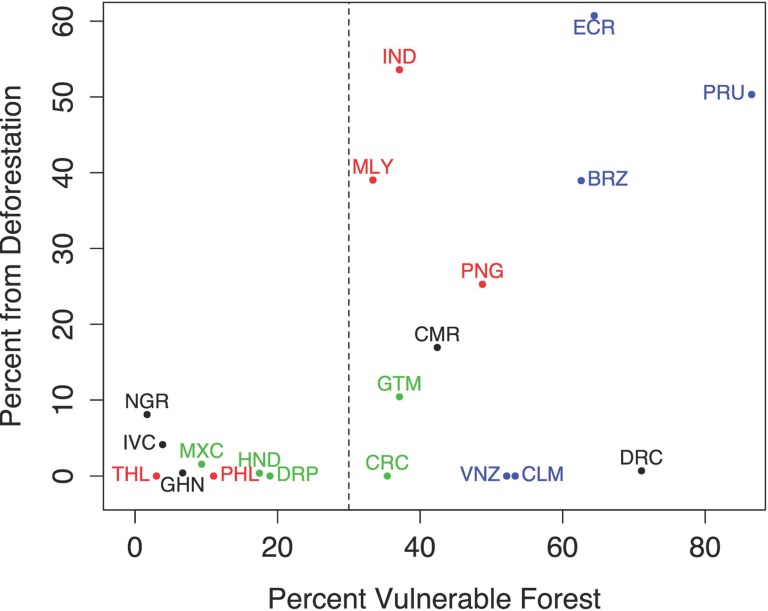
Percent deforestation versus percent vulnerable forest.Percent deforestation in sampled oil palm plantations (1989–2013) versus percent vulnerable forest within suitable area for oil palm (2013). Shown for all 20 sample countries. Colours indicate region: Blue-South America, Green-Mesoamerica, Black-Africa, and Red-Asia. Country name abbreviations: BRZ-Brazil, CMR-Cameroon, CRC-Costa Rica, DRC-Democratic Republic of Congo, DRP-Dominican Republic, ECR-Ecuador, GHN-Ghana, GTM-Guatemala, HND-Honduras, IND-Indonesia, IVC-Ivory Coast, MLY-Malaysia, MXC-Mexico, NGR-Nigeria, PNG-Papua New Guinea, PRU-Peru, PHL-Philippines, THL-Thailand, VNZ-Venezuela.